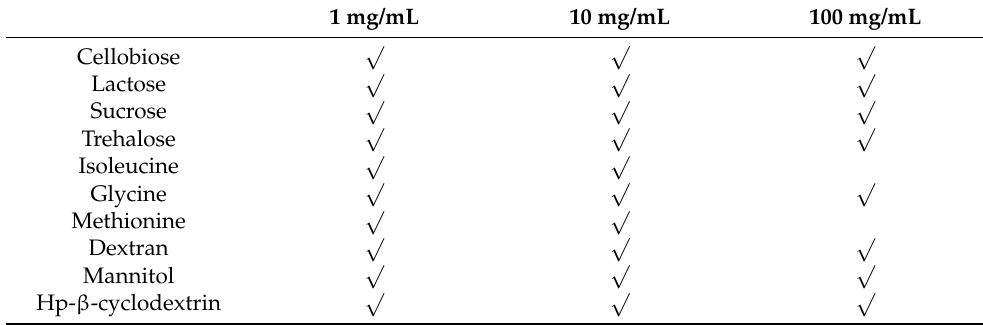
Table 1. List of the tested